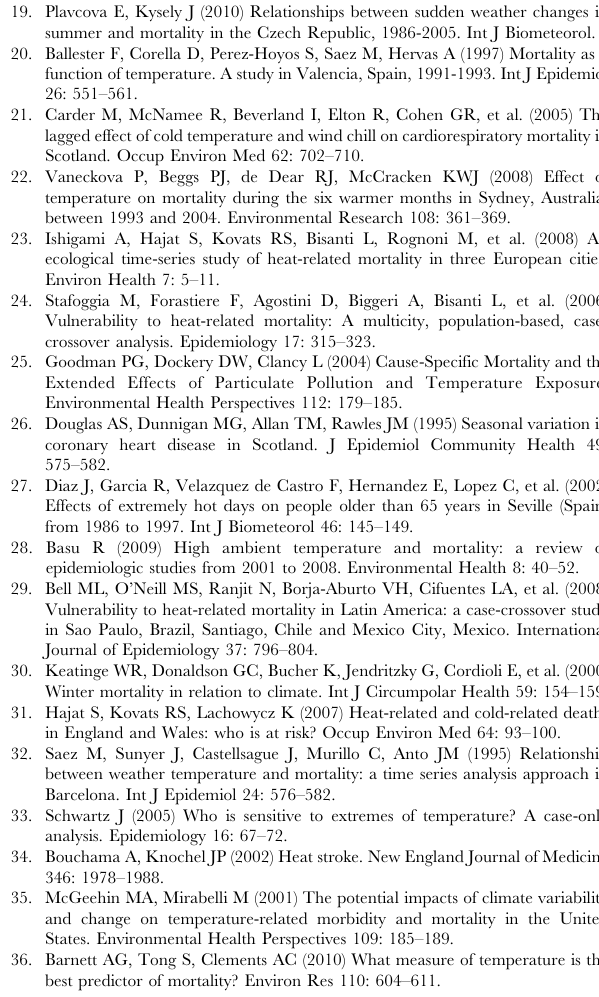
Figure S2 The associations between the mean temperature and age groups of non-external mortality using model (1) in Brisbane, Australia (left side) and Los Angeles, United States (right side). (TIF) Table S1 The associations between a 1 u C increase in mean temperature and mortality in Brisbane, Australia and Los Angeles, United States.